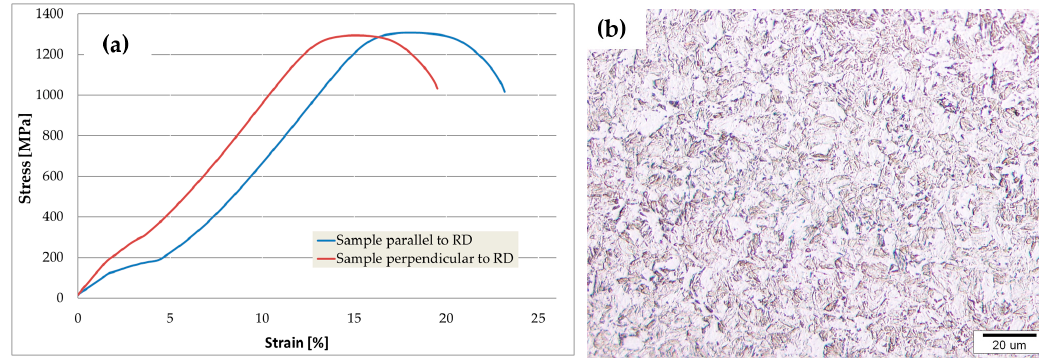
Figure 3. Properties of Docol 1200 U/AHHS in as-delivered condition; ( a ) engineering stress-strain diagram of the specimens sectioned parallel and perpendicular to the rolling directions, ( b ) microstructure of the ”as-delivered” condition.